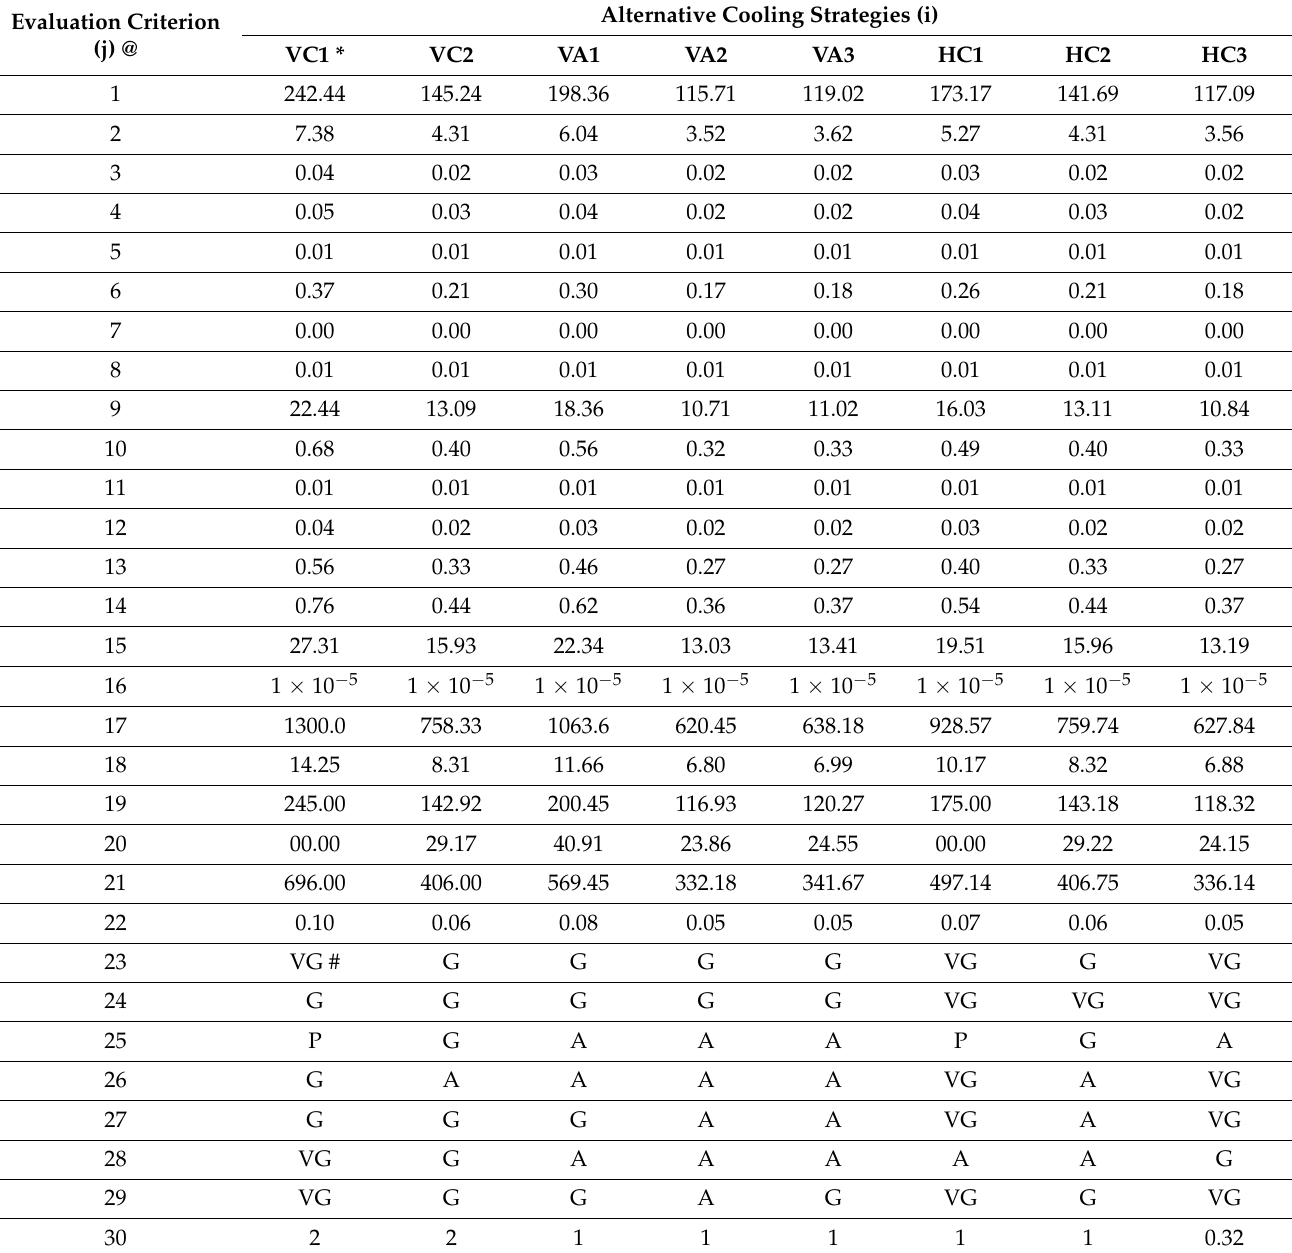
Table 3. The data of evaluation criterions corresponding to cooling strategies for maritime arid climate. Evaluation